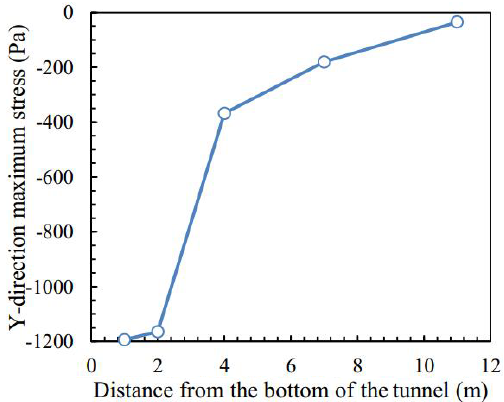
Figure 8. Cumulative settlement curve with steps.